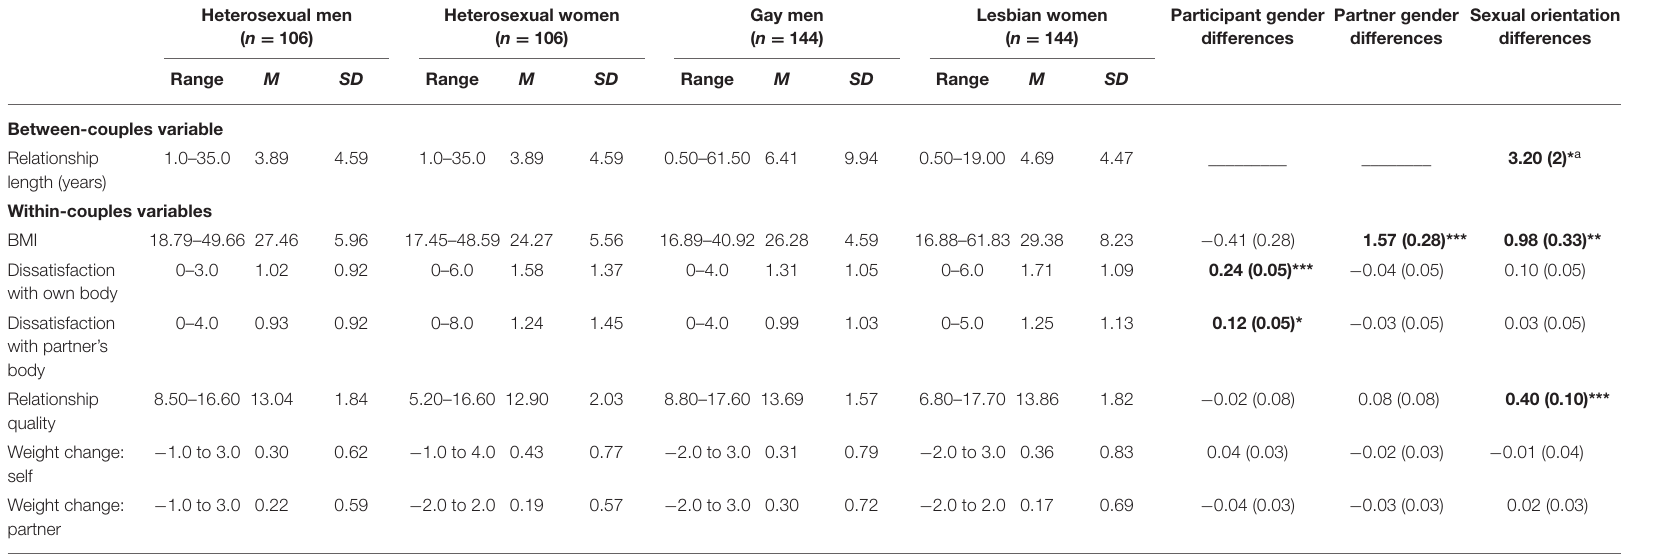
TABLE 1 | Descriptive statistics for key study variables by gender and sexual